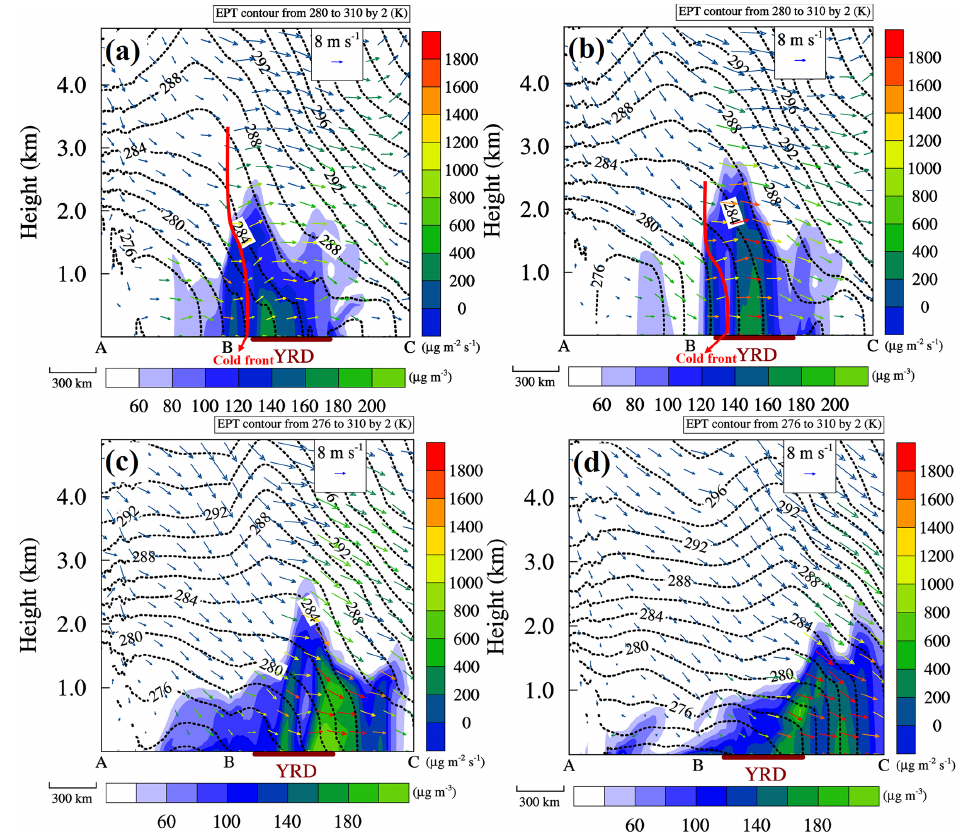
Figure 6. Vertical cross sections of PM 2 . 5 concentration (colour-filled contours), and equivalent potential temperature (EPT, dashed black lines), in-plane wind vectors (arrow) where the vertical speed is multiplied by 100, and PM 2 . 5 flux (arrow colour), at (a) 12:00LT 21 January, (b) 16:00LT 21 January, (c) 22:00LT 21 January, and (d) 04:00LT 22 January. The thicker red lines in panels (a) and (b) denote the locations of the cold